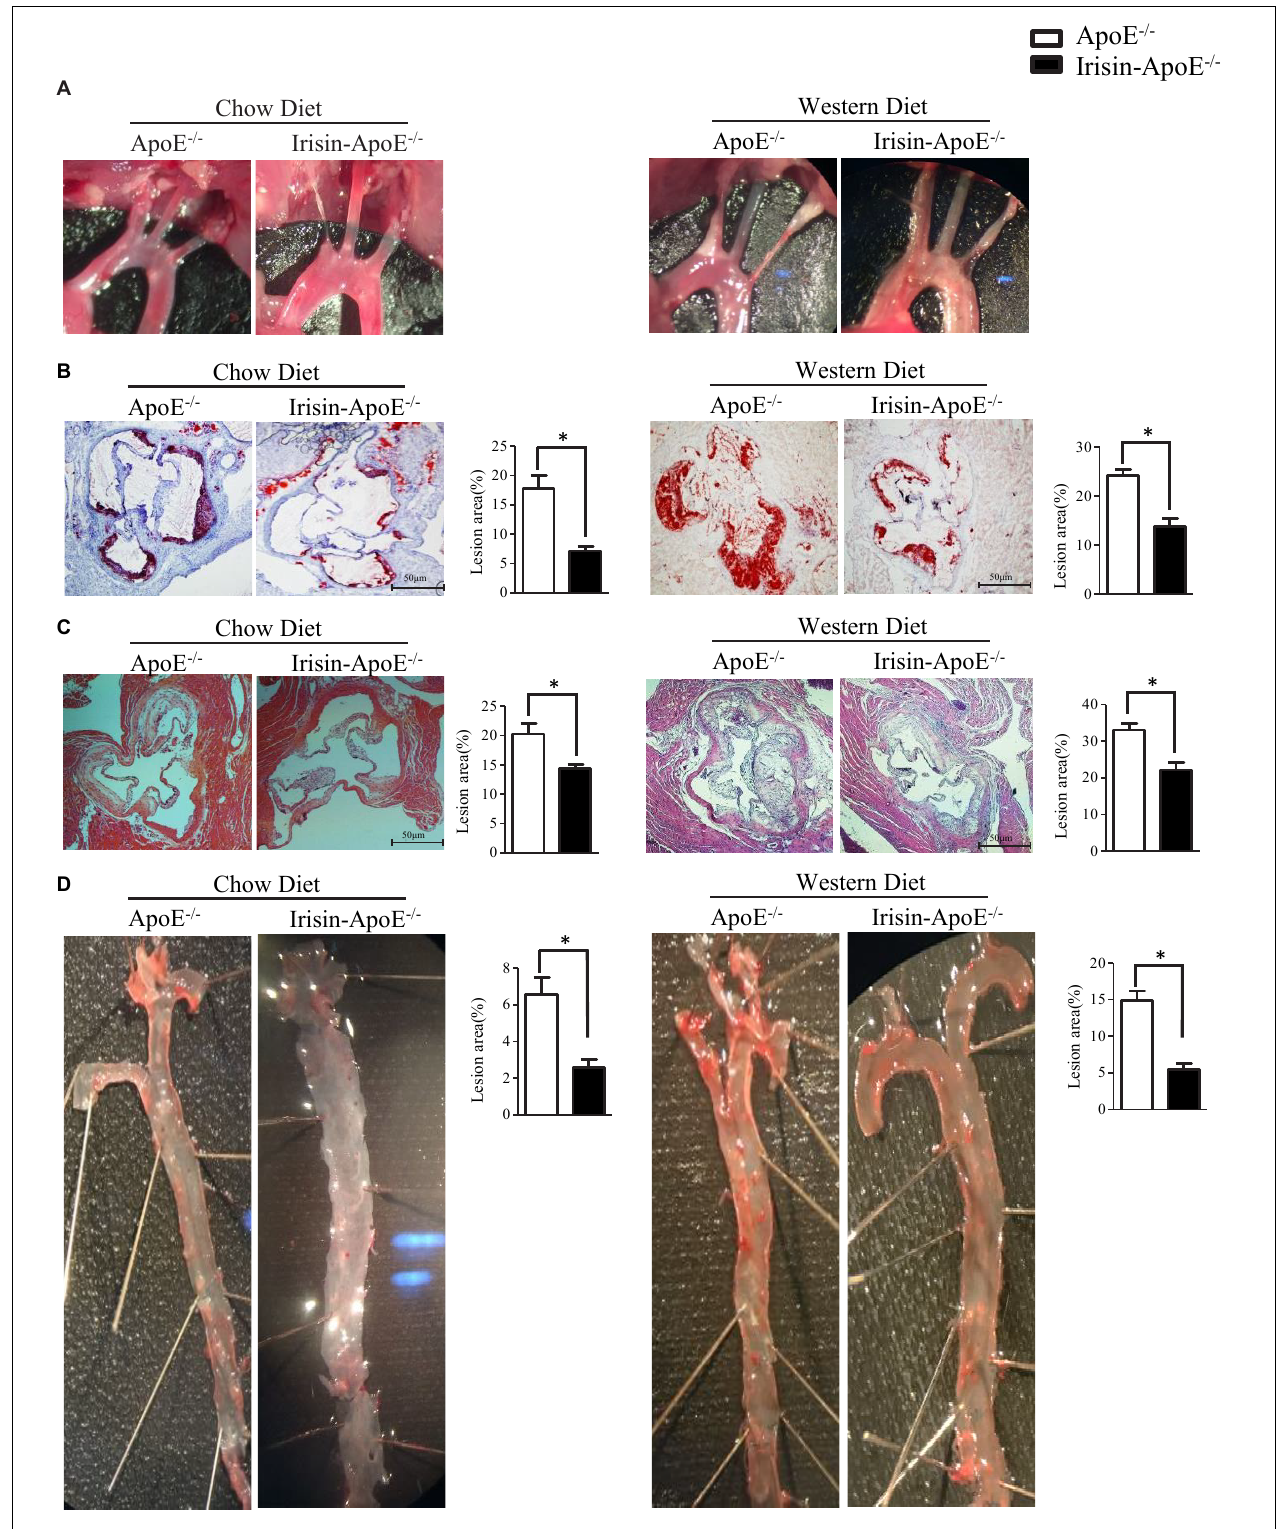
FIGURE 6 | Irisin alleviated atherosclerotic plaque formation in ApoE − / − mice. (A) Aortic arch in ApoE − / − and Irisin-ApoE − / − mice. (B,C) Oil-red O and H&E ( n WT = 5, n TG = 6) staining of aortic root. (D) Oil-red O staining of whole aortas of ApoE − / − and Irisin-ApoE − / − mice ( n WT = 5, n TG = 6). Data are mean ± SEM. ∗ P < 0.05.